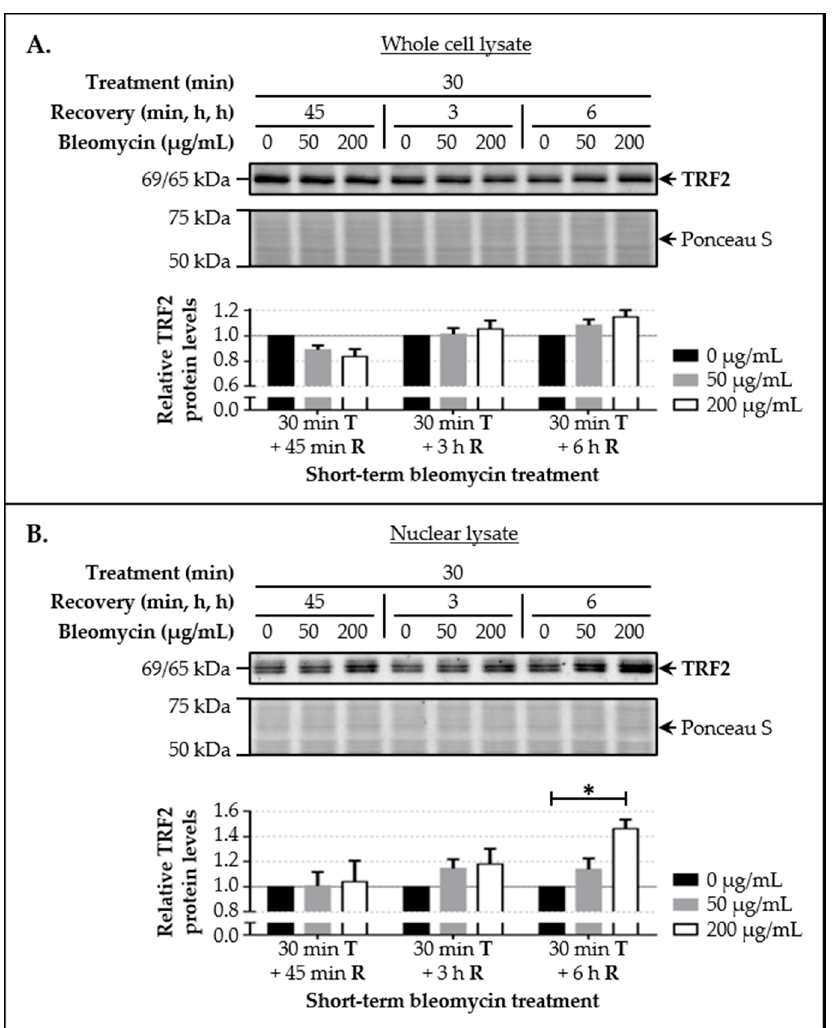
Figure 5. Evaluation of the e ff ects of DNA damage induced by a short-term bleomycin treatment on TRF2 protein levels in the human HeLa cell line. ( A ) Relative TRF2 protein levels in whole cell lysates after cell exposure to 50 and 200 µ g / mL of bleomycin for 30 min (T), followed by 45 min, 3 h and 6 h of recovery (R) (estimated in relation to untreated cells (0 µ g / mL) at each timepoint). ( B ) Relative TRF2 protein levels in nuclear lysates in the same experimental conditions specified in ( A ). Following treatment, HeLa cells’ total and nuclear extracts were analyzed by immunoblotting using a specific antibody against TRF2 to evaluate their protein levels. A representative blot is shown for each type of cellular lysate used. Quantitative data are presented as mean ± SEM ( n = 4). Before determining relative TRF2 protein levels, data normalization was performed using Ponceau S staining as protein loading control. * p < 0.05 for comparisons between control and treatment conditions using the Kruskal–Wallis test followed by the Dunn’s multiple comparison test. SEM, standard error of the mean; TRF2, telomeric repeat-binding factor 2.